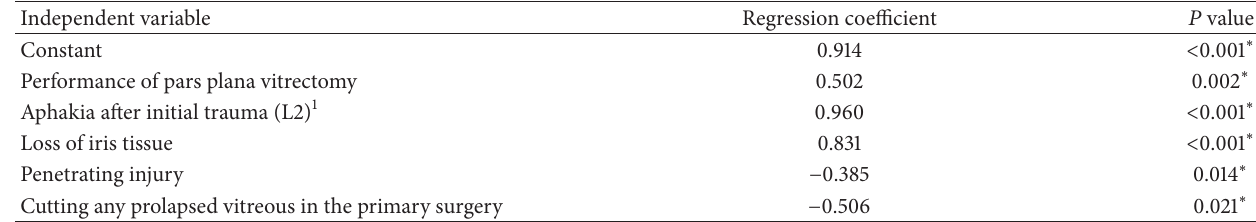
Table 4: The significant independent variables after the backward stepwise